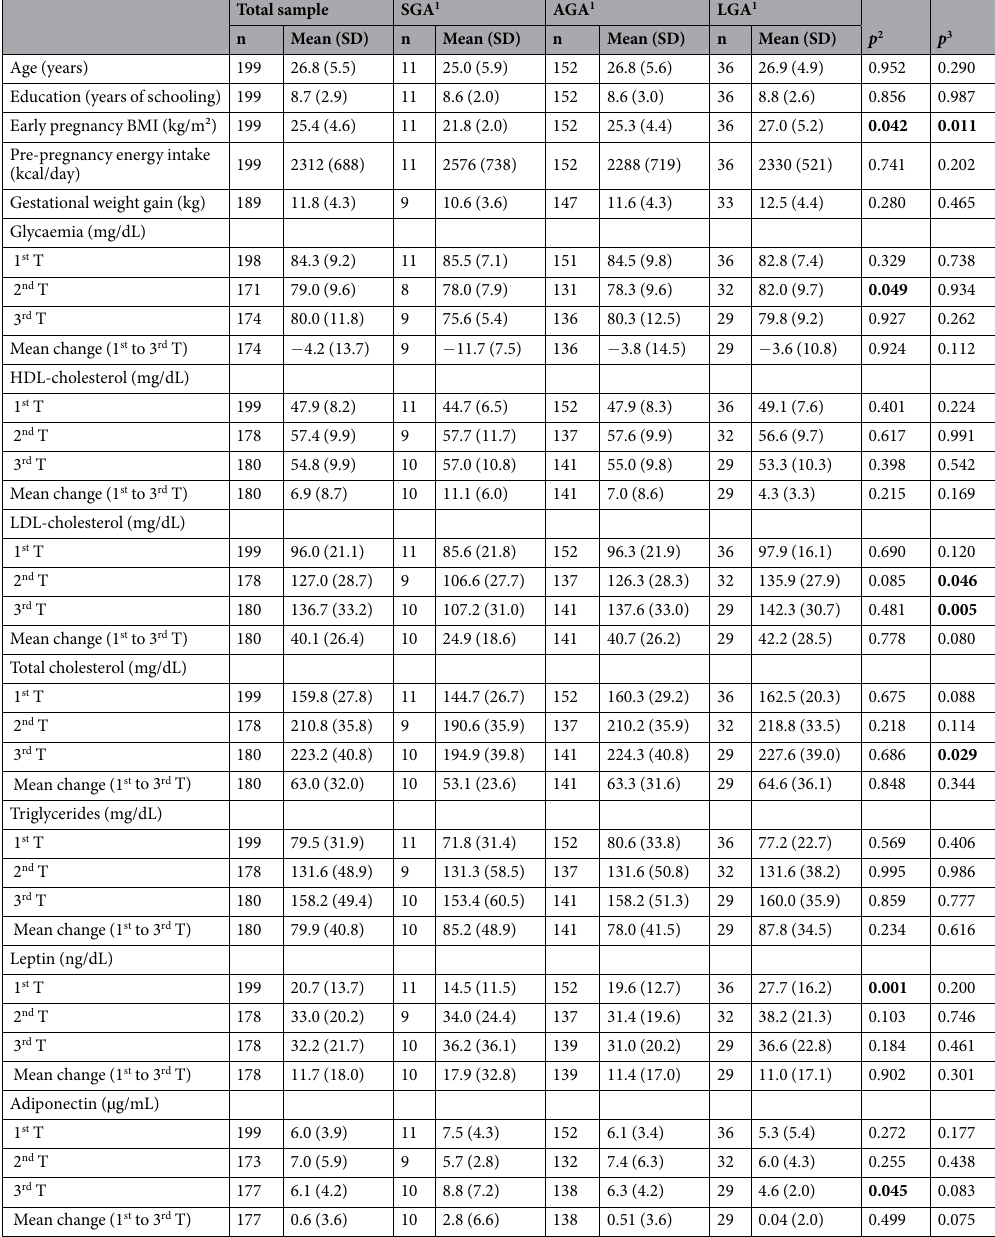
Table 1. Pregnancy characteristics according to birth weight categories in a sample of pregnant women and their newborns followed at a public health centre in Rio de Janeiro city, Brazil, 2009–2012. 1 Birth weight was classified according to the international foetal and newborn growth consortium for the 21 st Century (Intergrowth-21 st ) curves. 2 p-value refers to Student’s t test comparison between AGA and LGA. 3 p-value refers to Student’s t test for comparison between AGA and SGA. AGA = adequate for gestational age; BMI = Body mass index; HDL-c = high density lipoprotein; LDL-c = low density lipoprotein; LGA = large for gestational age; SD = standard deviation; SGA = small for gestational age; T =